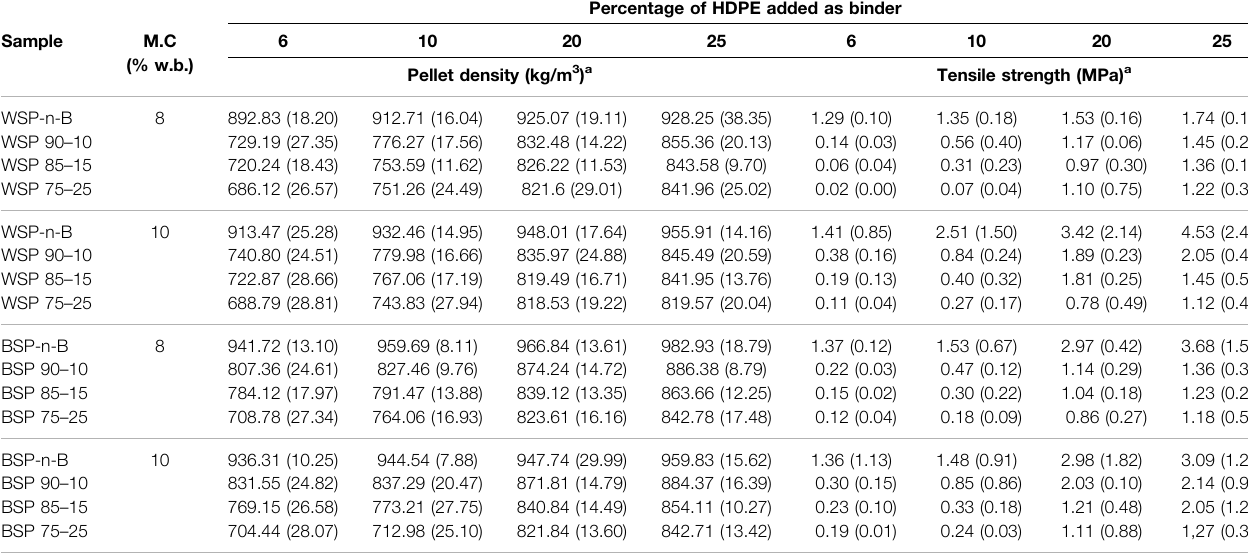
TABLE 4 | Pellets density and tensile strength characteristics of microwave-torre fi ed wheat and barley straw biochar at different HDPE blends.